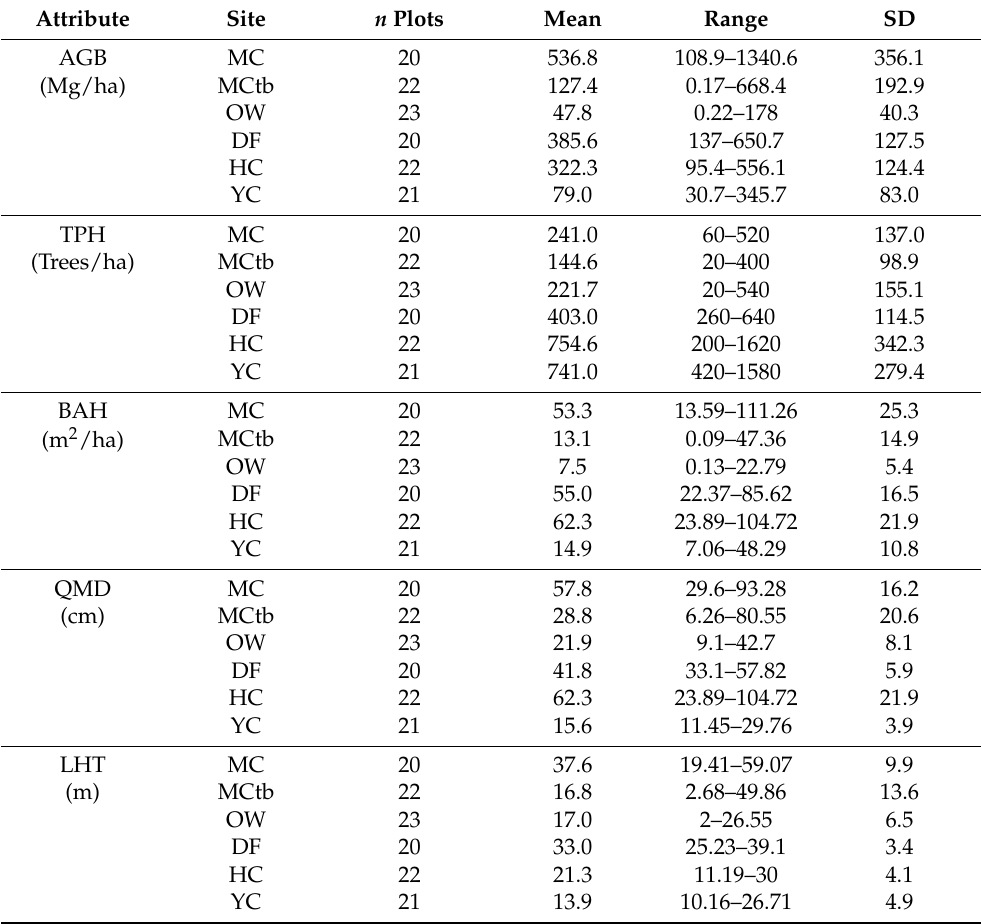
Table 1. Summary statistics of plot-level forest attributes at each site calculated from field data. Attribute Site n